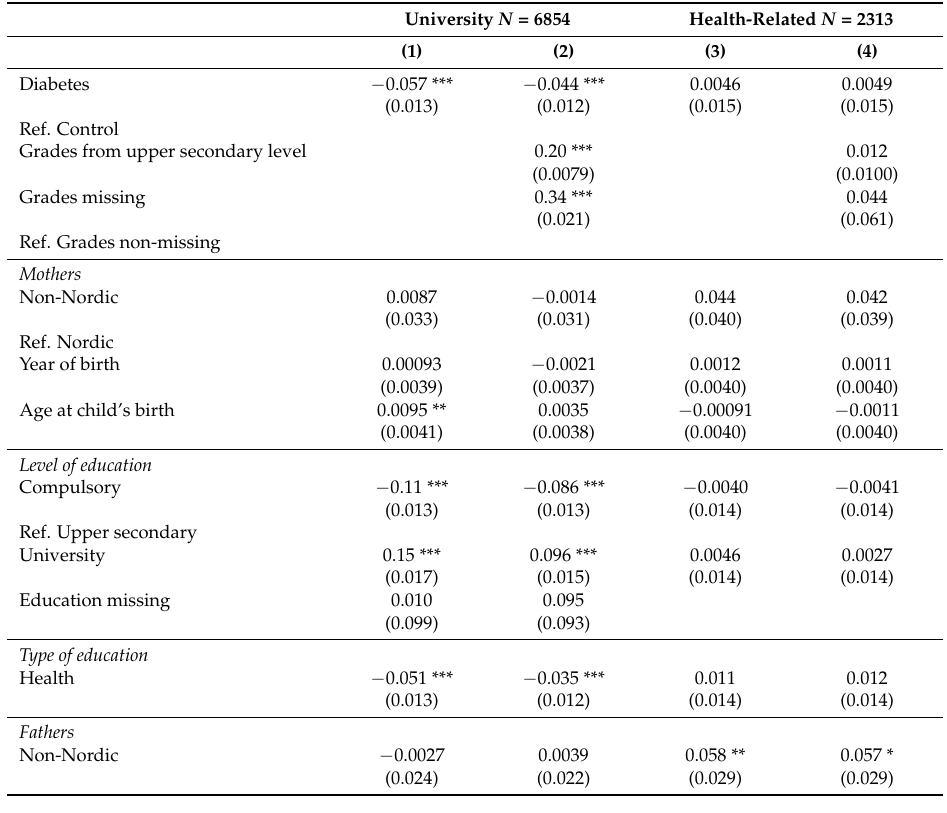
Table 6. Average marginal effects of men’s probability of having a university education and the probability of having a health-related university education for those with a university